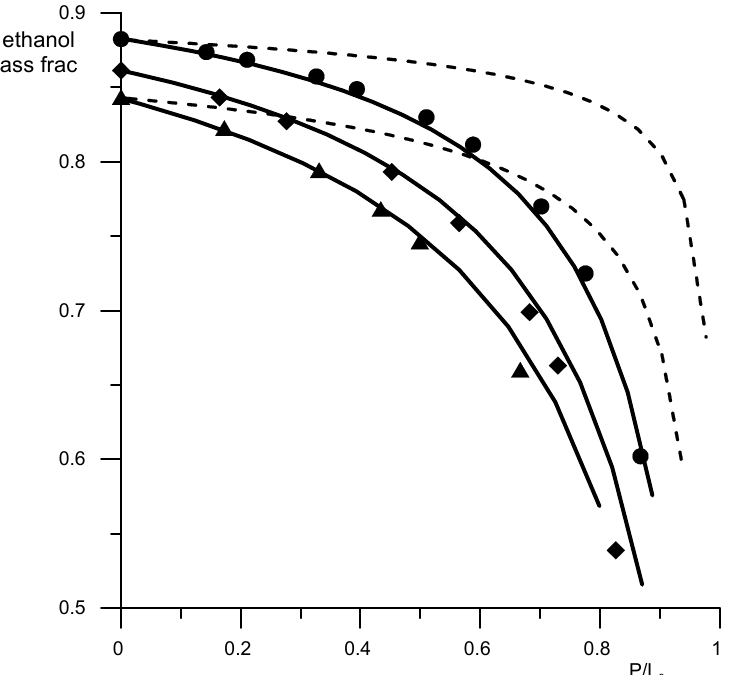
Figure 5. Residual curves for the ethanol–water–AEBA-TEG mixture. Geometric figures are experimental values (circles — AEBA-TEG 20 wt %, rhombuses — AEBA-TEG 40 wt %, triangles — AEBA-TEG 60 wt %), and continuous lines are calculated values. Dotted lines — calculated values for the ethanol–water mixture without AEBA.